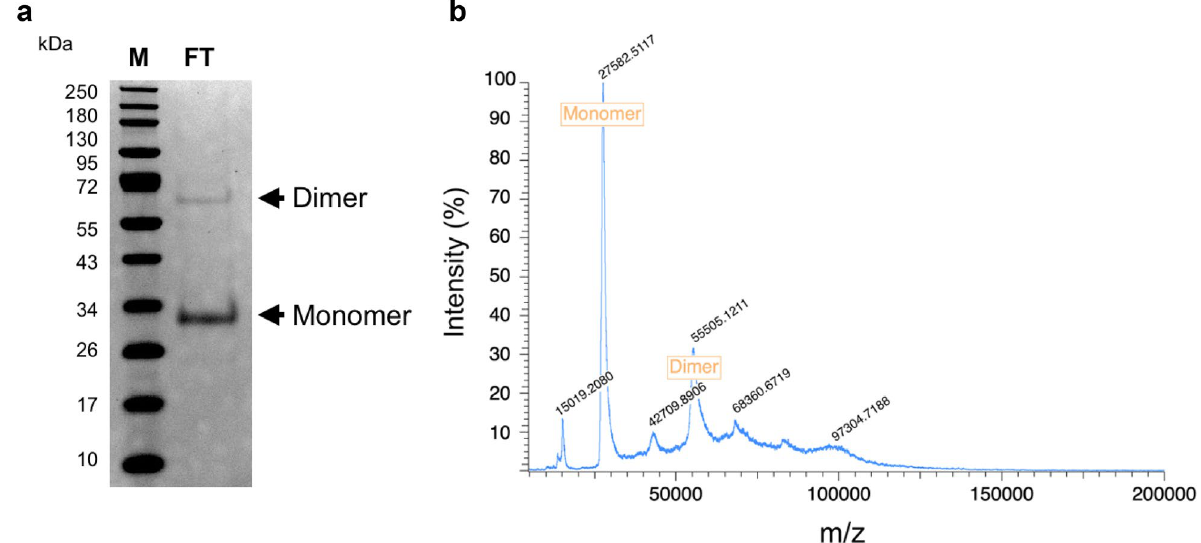
Figure 5. Second step purification of Thy1-scFv after proteolysis. ( a ) SDS-PAGE showing pure Thy1-scFv. M protein molecular weight marker, FT flow through. ( b ). Mass spectrometry on Thy1-scFv flow through fraction.